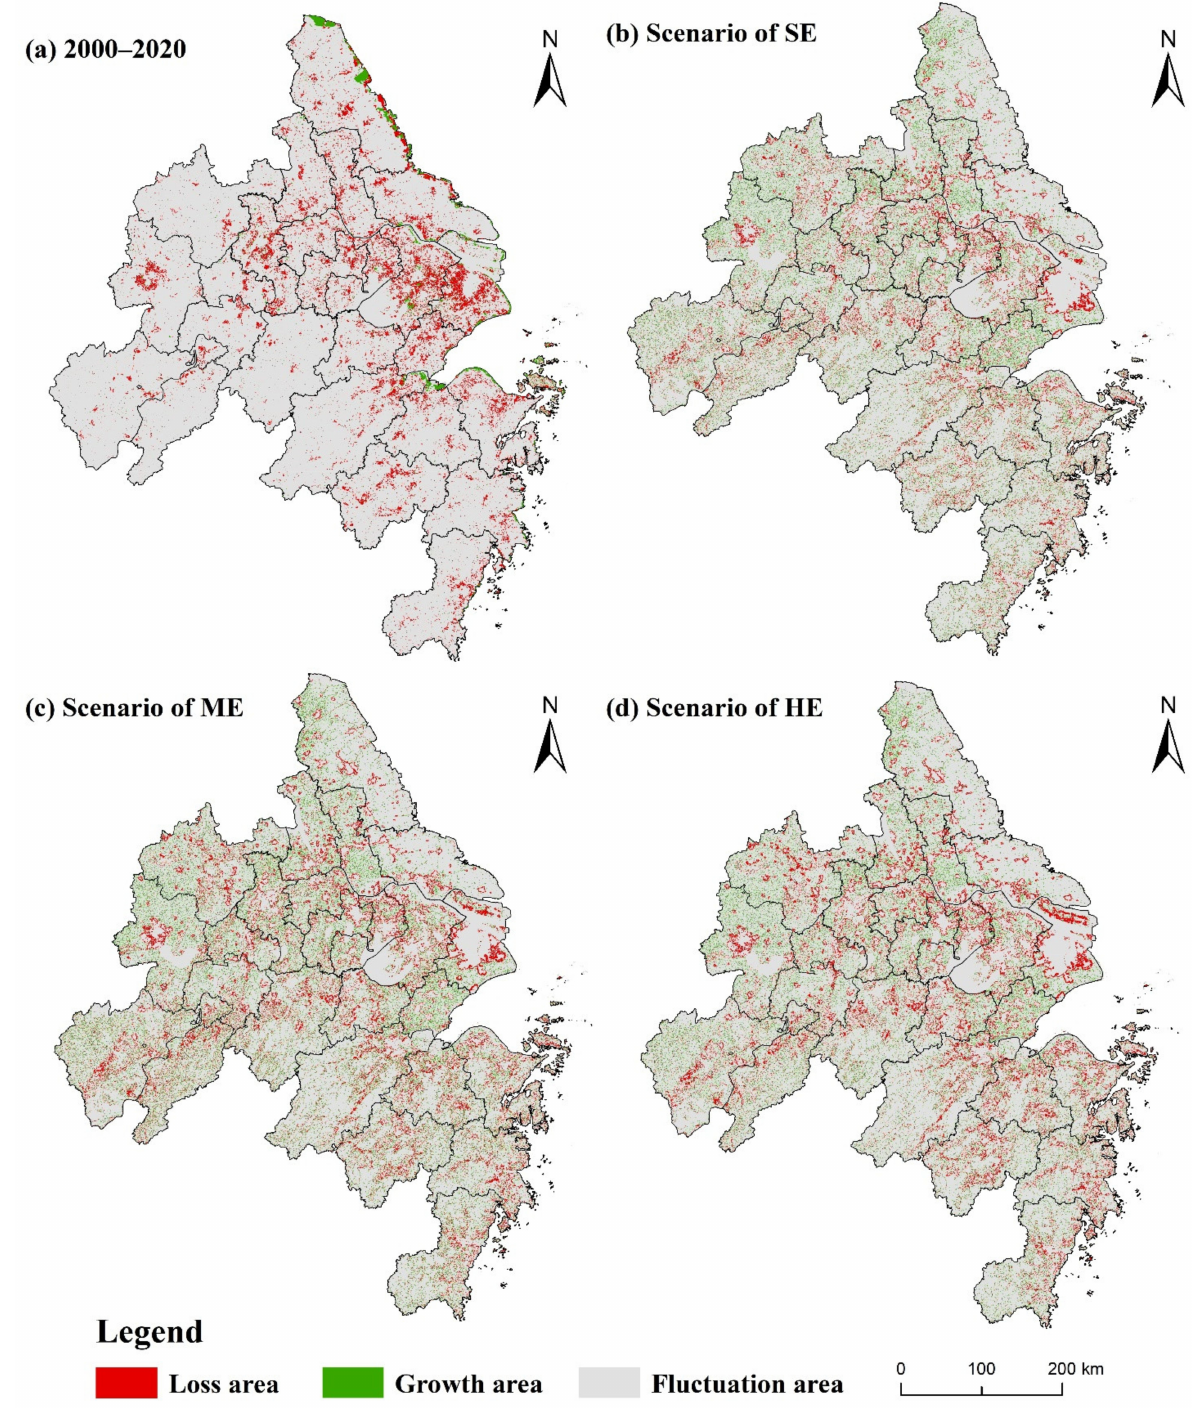
Figure 8. Spatial distribution of carbon storage loss in YRD: ( a ) from 2000 to 2020; ( b – d ) from 2020 to 2035 under the scenarios of SE, ME, and